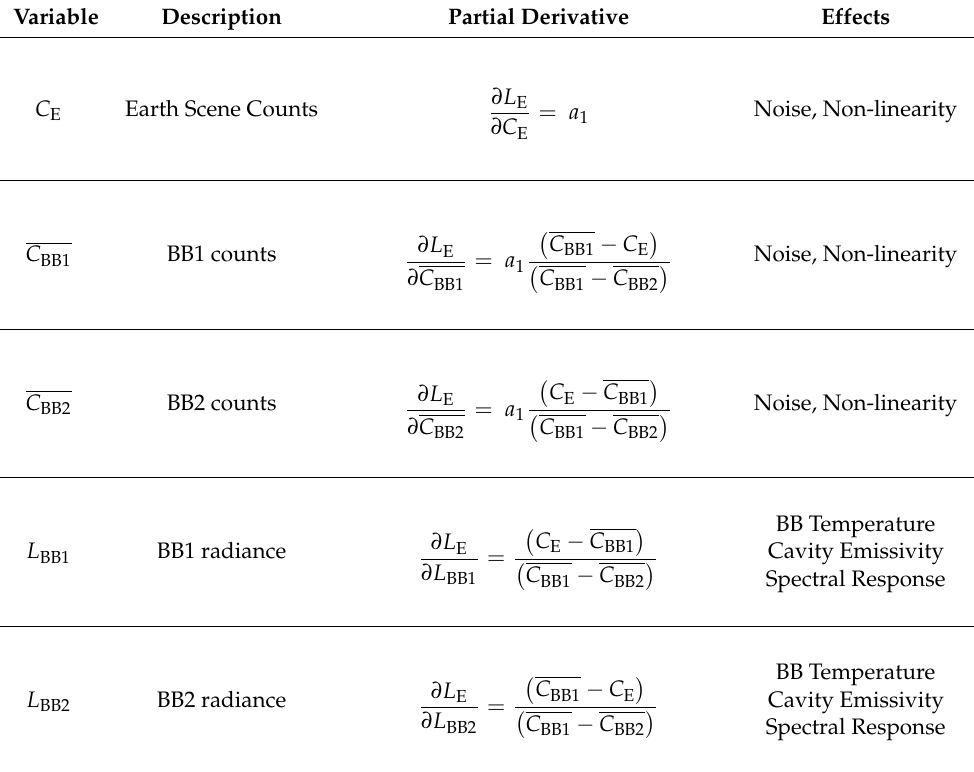
Table 1. Table of primary contributions to uncertainties in SLSTR calibration